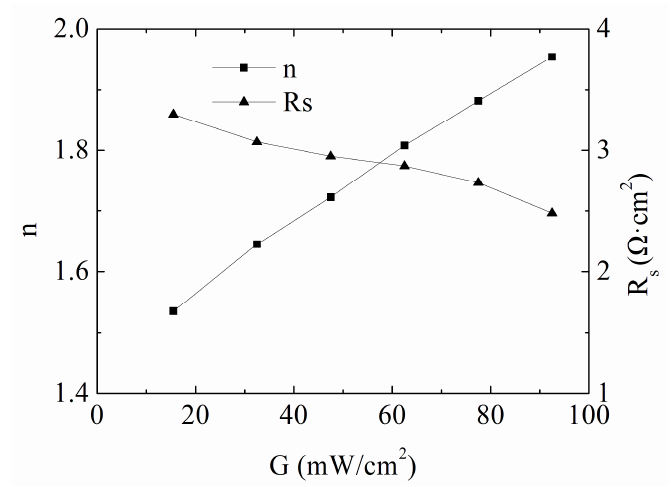
Figure9. Intensity G versus n and R s